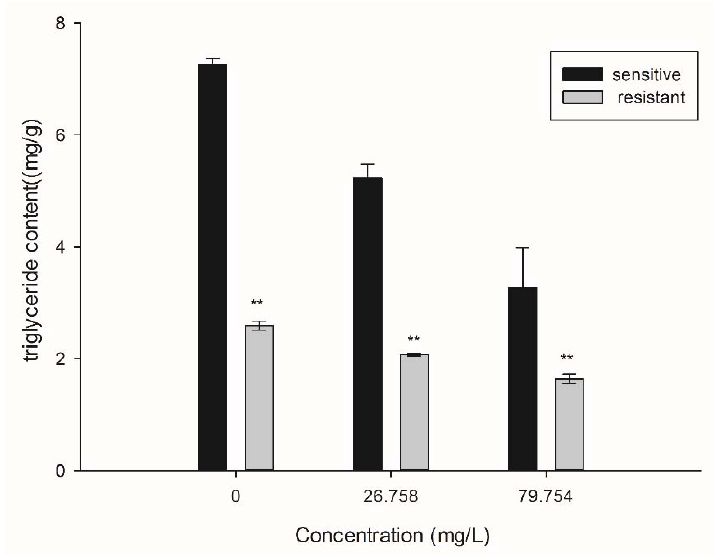
Figure 5. Effect of SYAUP-CN-26 on the triglyceride synthesis (TG) of B. cinerea. Values are pre- sented as mean ± S.E. (n = 3) and are significant for ** p < 0.01.